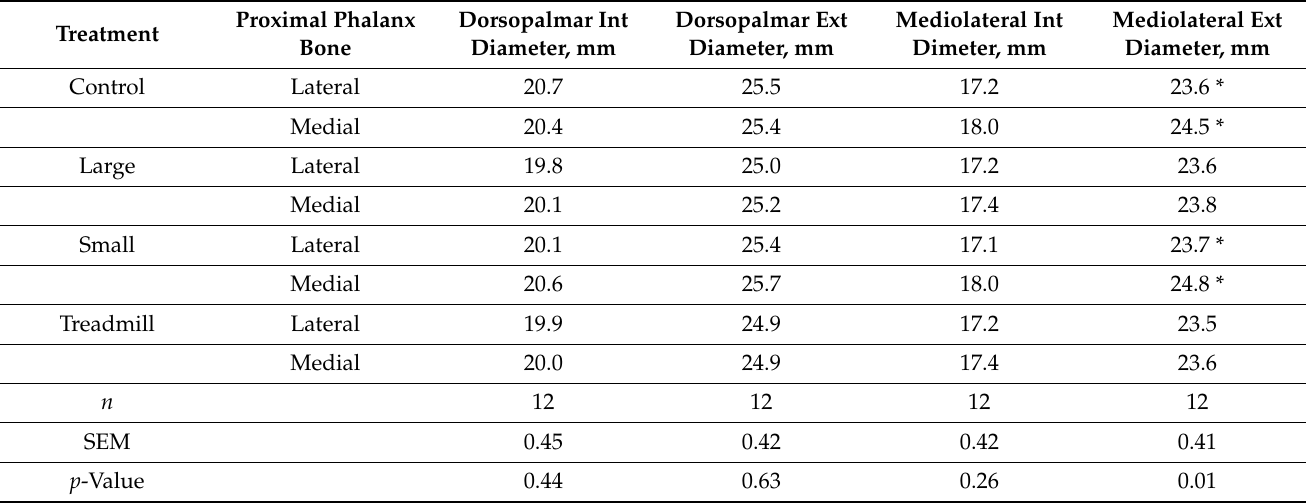
Table 4. Internal (int) and external (ext) cortical diameters of the lateral and medial proximal phalanx of both front